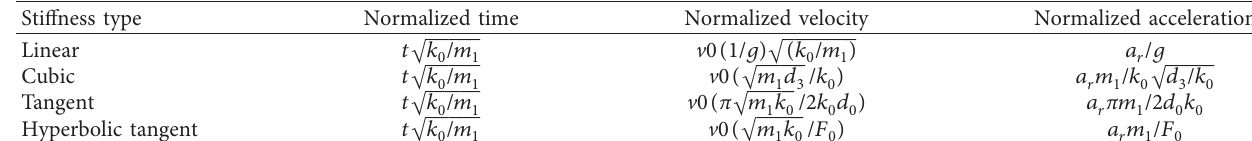
Table 3: Normalized formulas of different cushioned packaging systems.